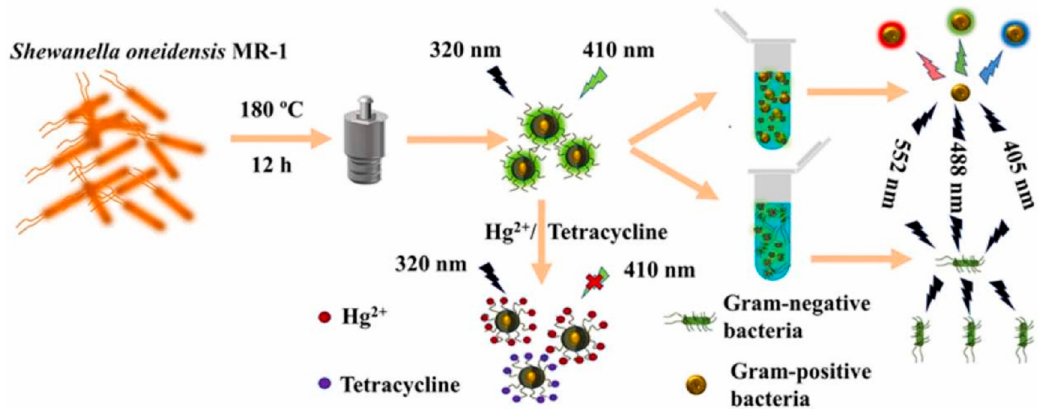
Figure 14. The synthesis of CDs@MR-1 and its application to identify Gram-positive bacteria from Gram-negative bacteria (reprinted with permission from [175], 2022, Elsevier).